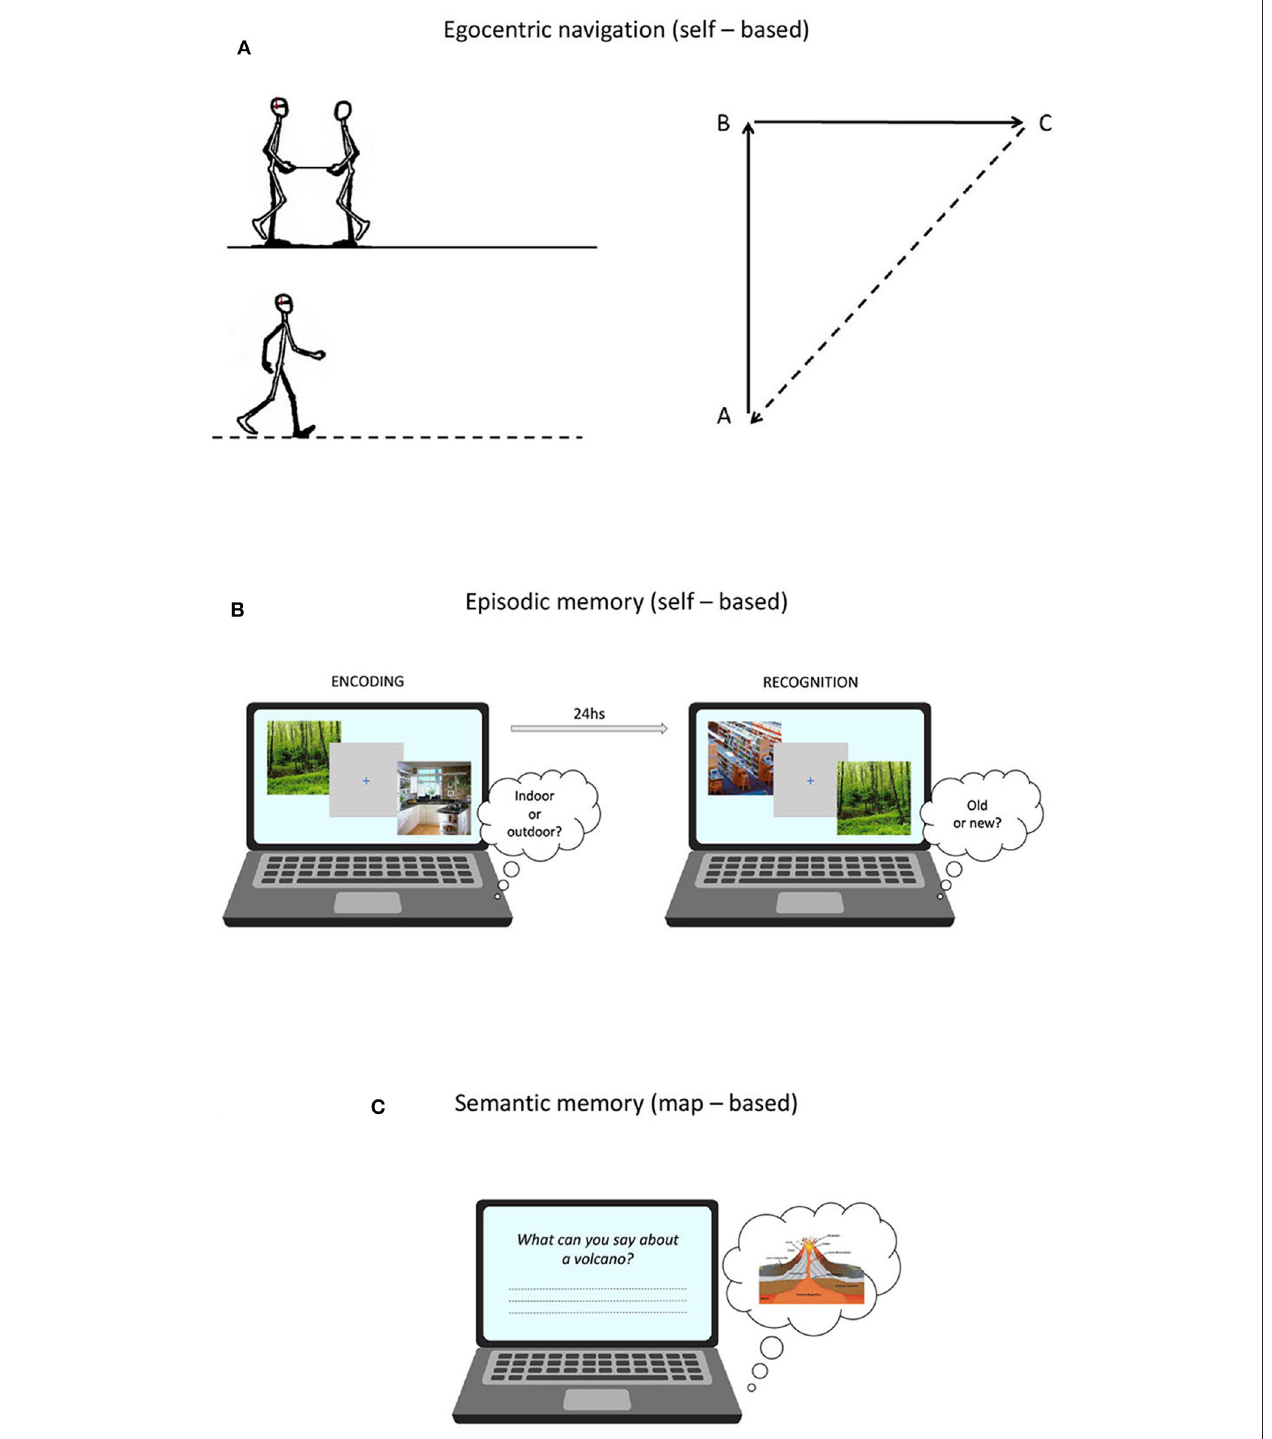
FIGURE 1 | (A) Proprioceptive Triangle Completion Task (pTCT) used to asses egocentric navigation; (B) Picture Recognition Task (PRT) used to asses episodic memory; (C) General Knowledge of the World questionnaire (GKW) used to asses verbal semantic memory. semantic memory by conducting a partial correlation analysis between the pTCT and the PRT scores (IBM SPSS Statistics between the pTCT and the GKW score with the PRT score 25). Similarly, we controlled for the effect of the episodic as a memory over the relationship between egocentric navigation and